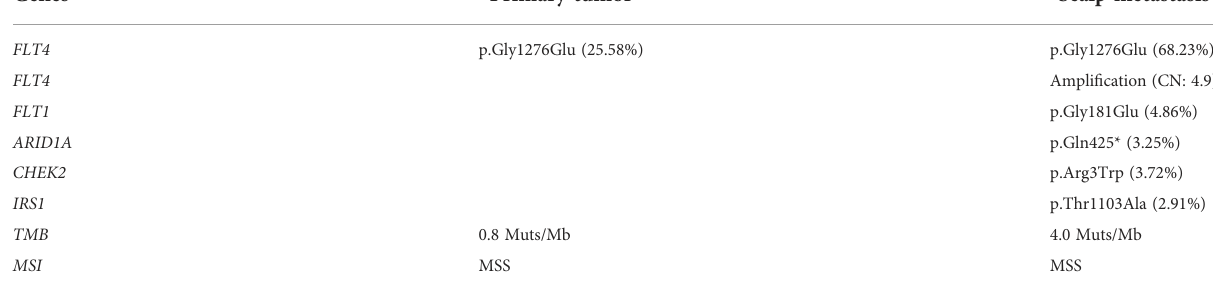
TABLE 1 DNA-NGS detection results of the